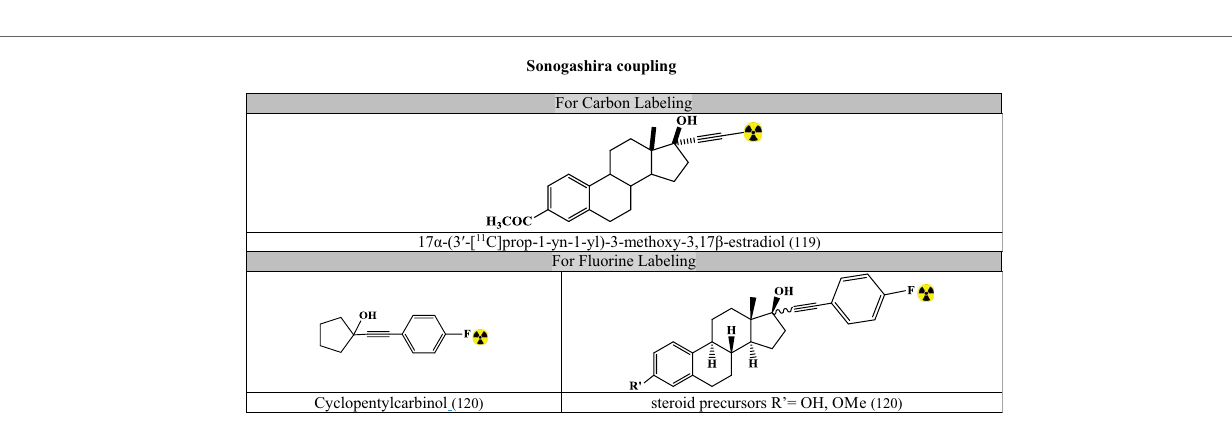
FiGURe 9 | Selected radiopharmaceuticals developed using Sonogashira coupling. Structures referenced in (80, 82, 119–120).